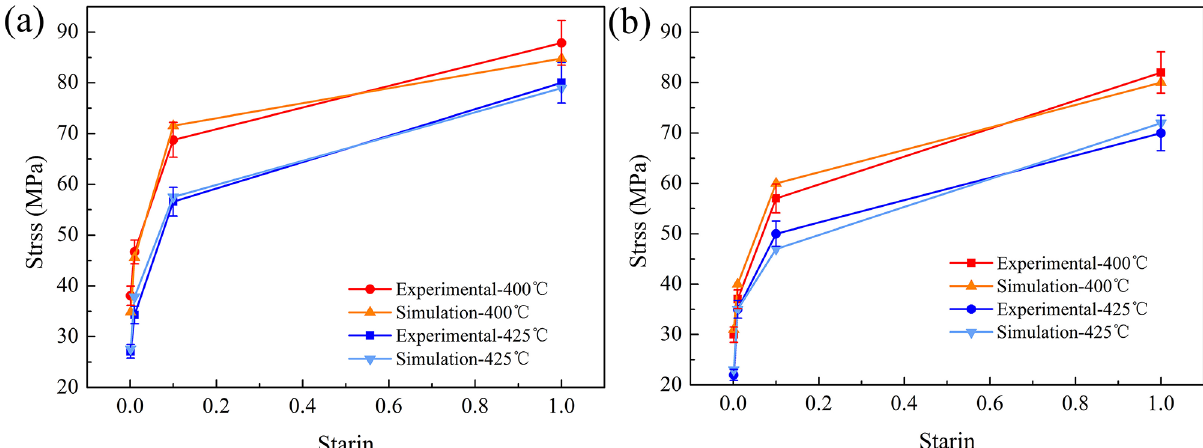
Fig. 5. Comparison between peak stress and steady stress by experimental and simulation of AZ61 magnesium alloy sample ( T = 400 and 425 ° C, _ e = 0.001 – 1 s (cid:1) 1 ): (a) s p -strain, (b) steady stress-strain.